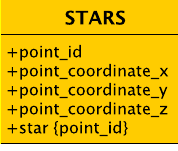
Figure 16: Stars UML